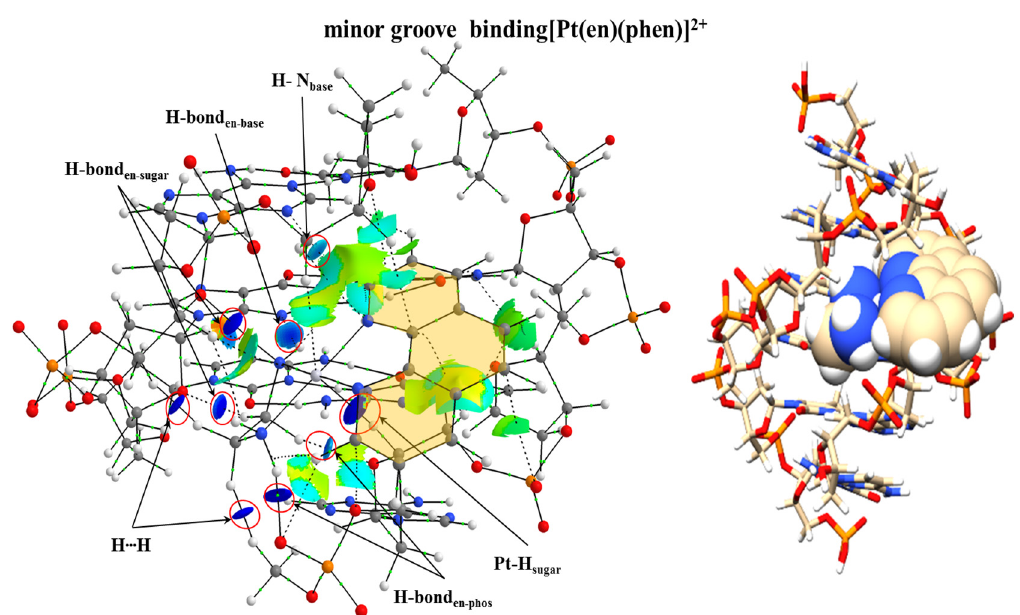
Figure 25. Optimized structure of the most stable system consisting on the [Pt(en)(phen)] 2+ metal complex interacting via groove binding with the d(GTCGAC) 2 hexamer of the dDNA, at PM6-DH 2 level, along with the reduced model used to calculate the NCI plot at the B3LYP/6-31G(d,p) level of theory for all the atoms except Pt, with the Hay-Wadt LANL2DZ effective core potential and the associated basis set.